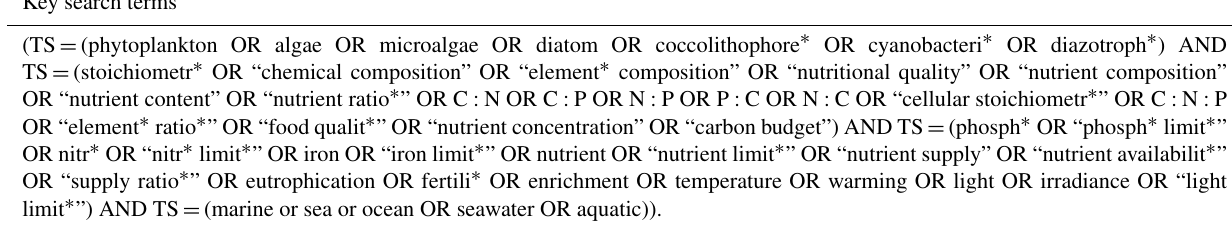
Table 1. Keyword search terms used for literature search (Web of Science, February 2019). In the search field, “TS” refers to a field tag for “topic” and “ ∗ ” is a wildcard search operator.